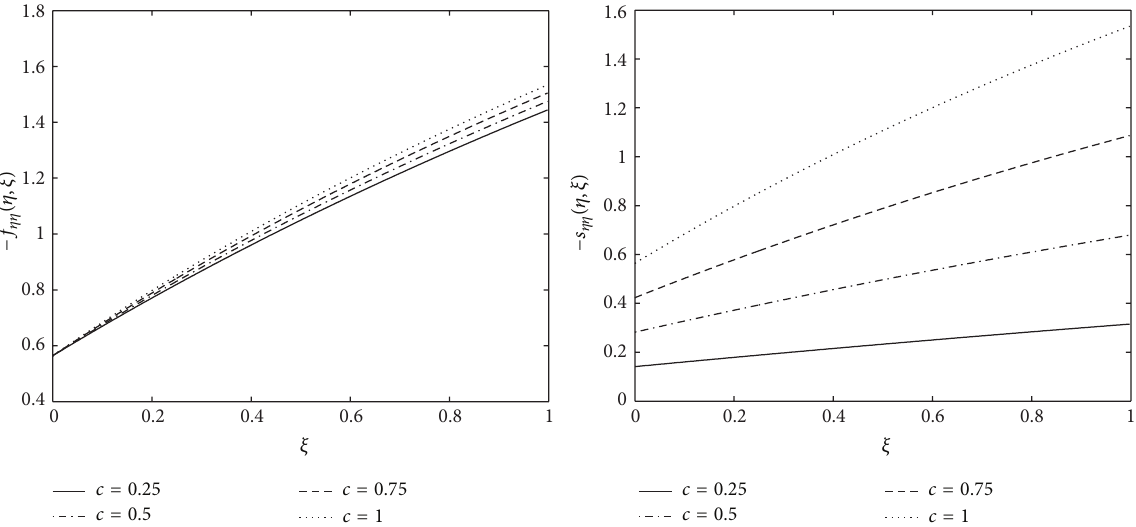
Figure 3: CFDRM solution of −𝑓 󸀠󸀠 (0, 𝜉) and −𝑠 󸀠󸀠 (0,𝜉) for different values of 𝑐 when 𝑀 = 1 and Pr = 0.7 .